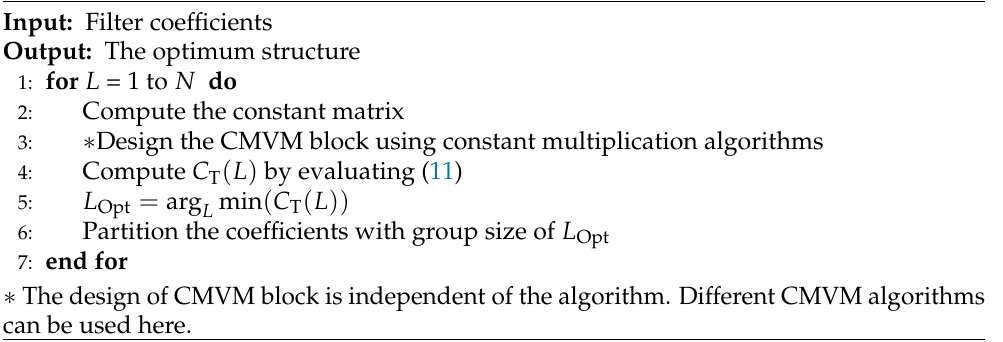
Algorithm 1 The exhaustive search